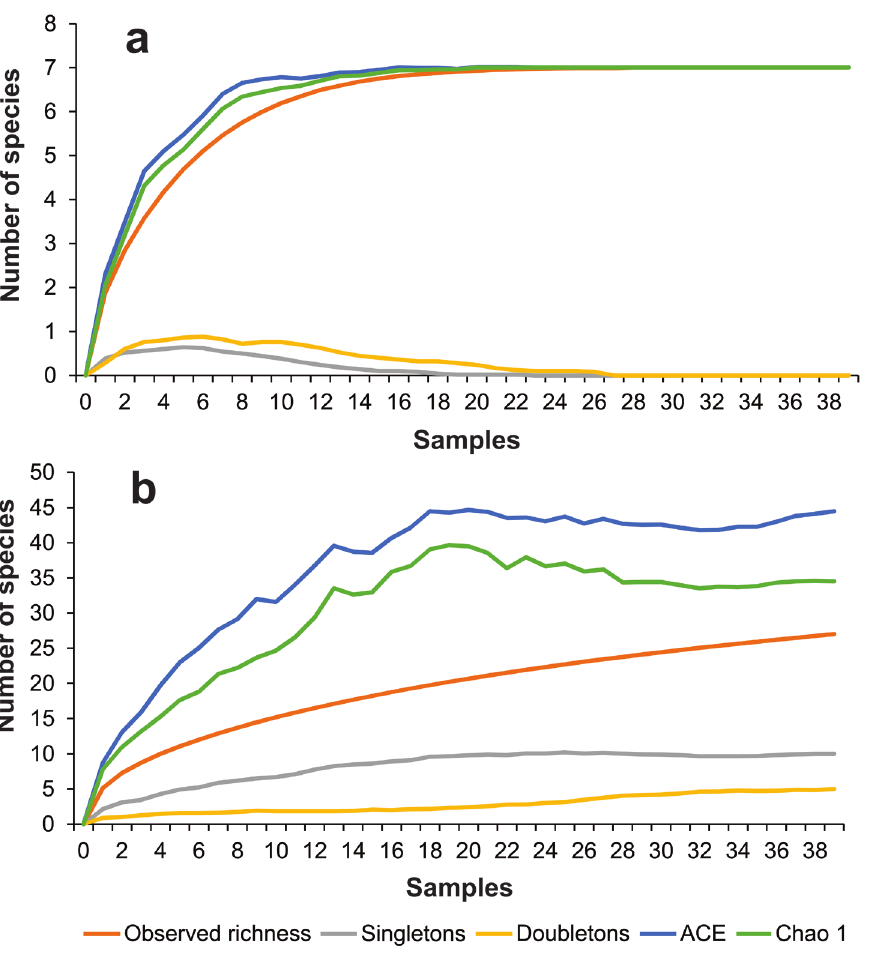
Figure 2. Species-accumulation curve for amphibians ( a ) and reptiles ( b ) inside of REBSSJ. Observed richness, species represented by a single individual (singletons), species with two individuals (doubletons), and estimated species (ACE and Chao